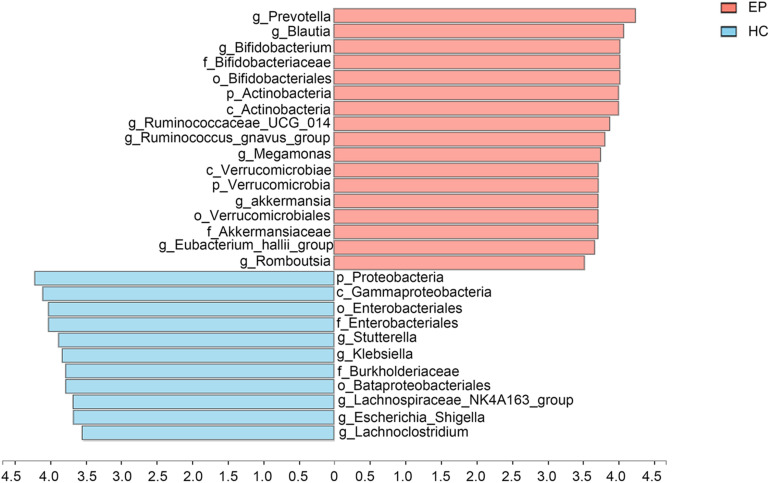
Marked differences in the abundance of fecal microbiome members at all taxonomic levels between EP and HC groups obtained by using the linear discriminant analysis (LDA) effect size (LEfSe) method; p < 0.05, LDA > 3.5. EP, patients with epilepsy; HC, healthy spouse-matched controls.